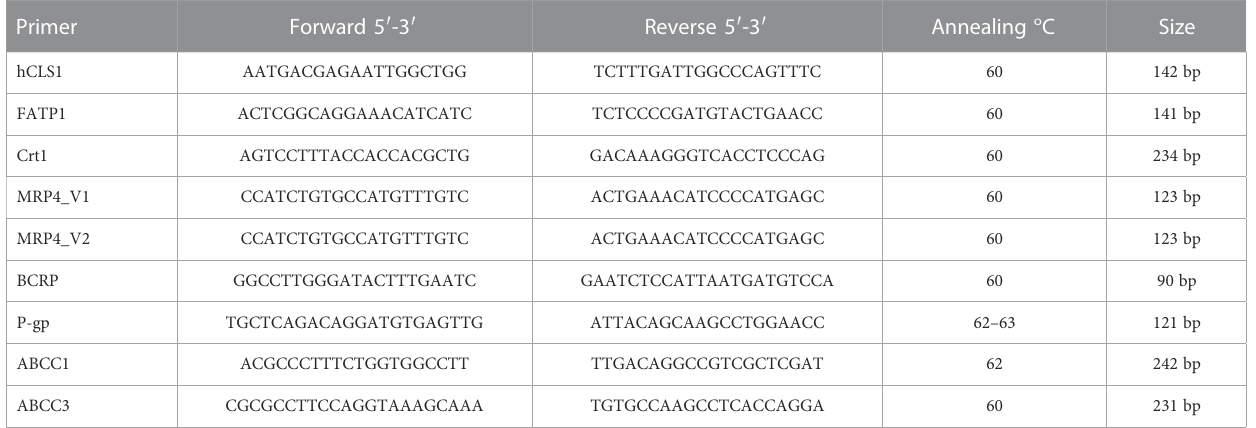
TABLE 1 Primers and annealing temperatures for RT-PCR and amplicon